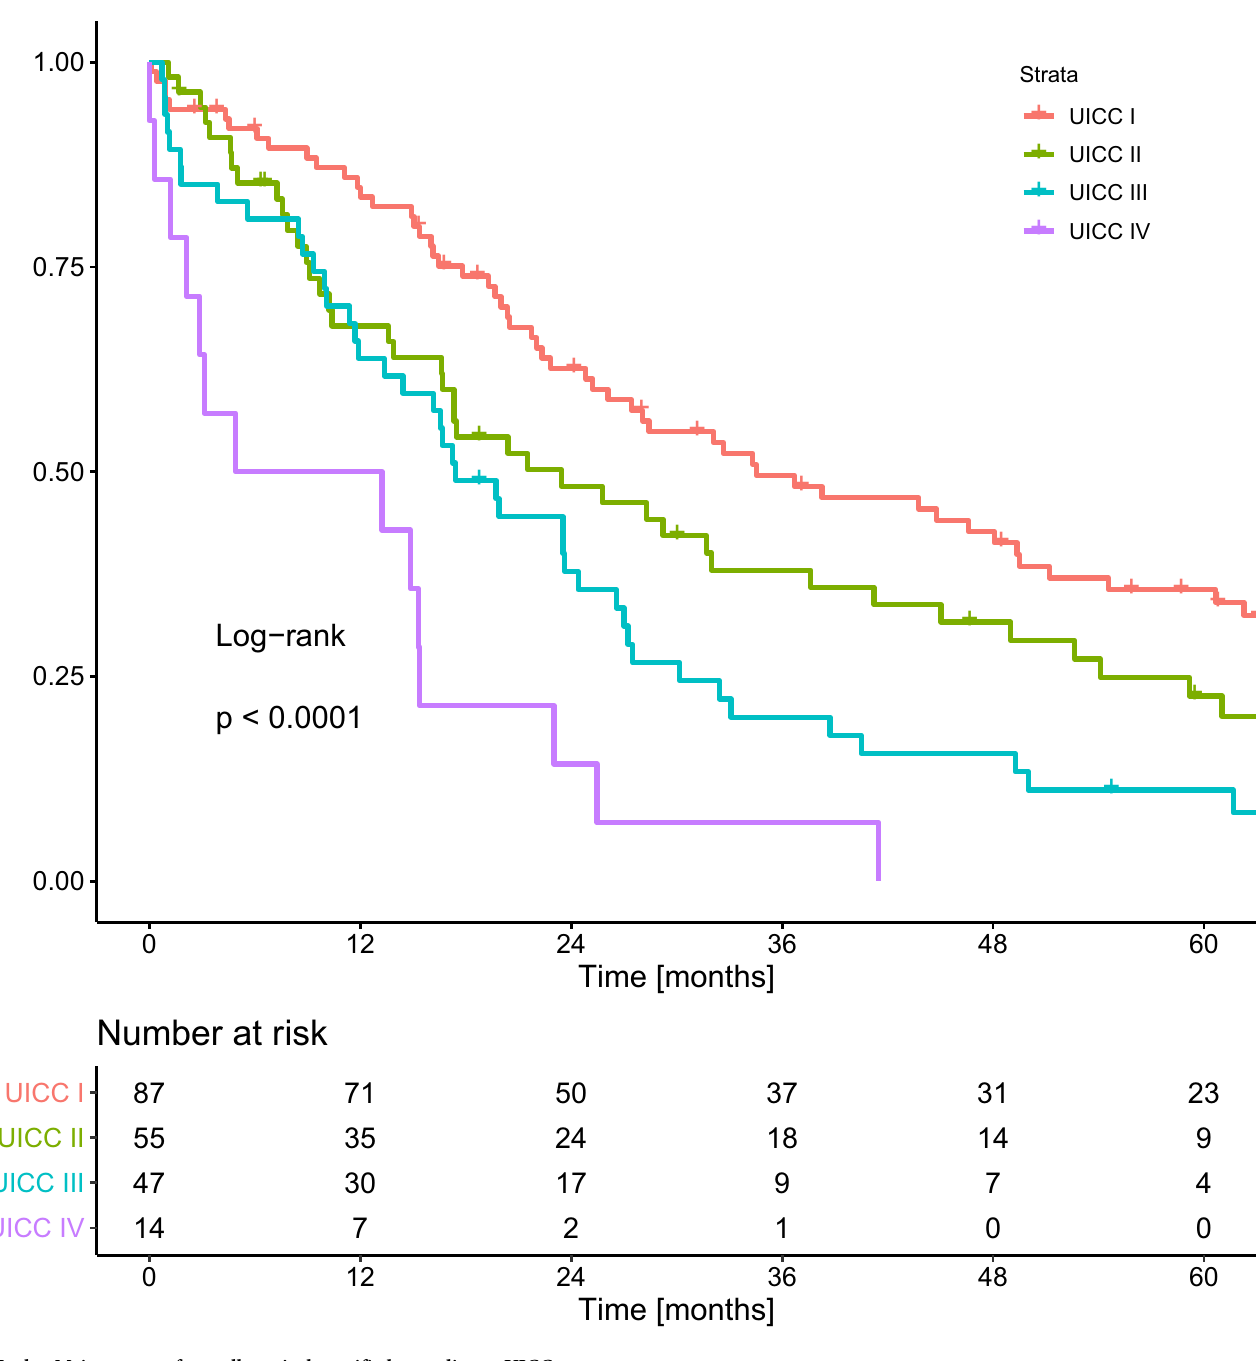
Fig 3. Kaplan Meier curves of overall survival stratified according to